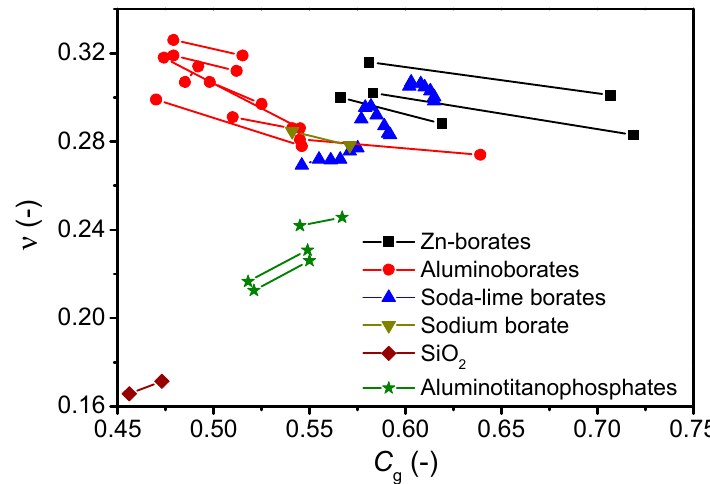
Figure 3. Effect of high-temperature densification, as quantified by the increase in atomic packing factor ( C g ), on the Poisson’s ratio ( ν ) of selected glasses: zinc borates (this study), aluminoborates (this study and Ref. [46]), soda-lime borates (Ref. [80]), sodium borate (Ref. [68]), SiO 2 (Ref. [68]), and aluminotitanophosphates (Ref. [68]). The errors associated with ν and C g are 0.01 and 0.002, respectively.